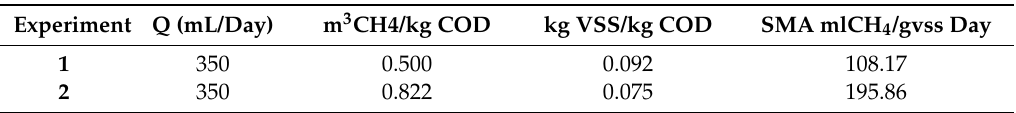
Table 10. Parameters of the anaerobic codigestion yield for the different experiments, where COD f is the chemical oxygen demand (mg/L), CH 4 methane m 3 /kg COD, VSS is volatile solids kg/kg COD, SMA specific methanogenic